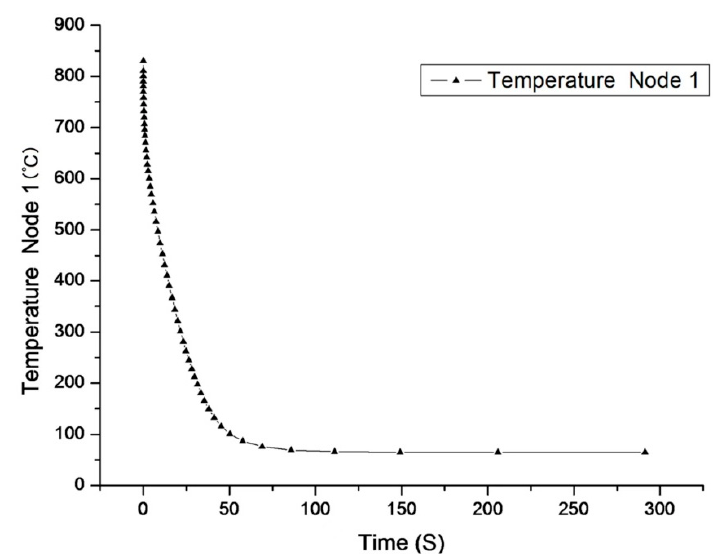
Figure 6. Cooling curve of node